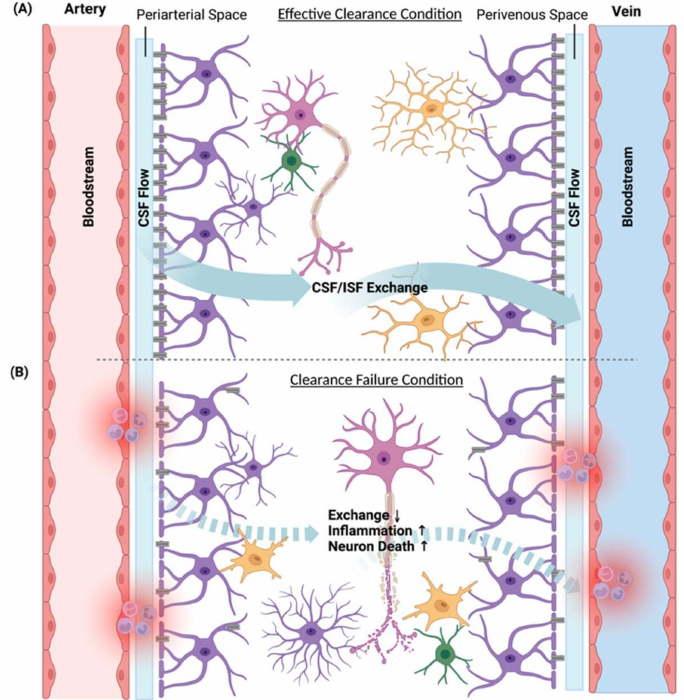
Figure 2. The glymphatic system. Structurally, the glymphatic space is a composite of the periarterial and perivenous space, surrounded by the blood vessel walls and vascular end-feet of astrocytes (in purple). Within the glymphatic spaces, arterial pulsations drive the flow of the cerebrospinal fluid (CSF), and the fluid enters the brain parenchyma via aquaporin-4 (AQP4) water channels. Lastly, this current will converge into the perivenous space. The exchanges between CSF and interstitial fluid (ISF) are particularly important for material exchanges and waste cleaning in the brain. Panel ( A ) shows effective cleaning of the metabolic waste in the glymphatic system. Neurons (in pink), microglia (in yellow), and astrocytes and oligodendrocytes (in green) are in normal conditions. In panel ( B ), during aging and chronic inflammation, a significant reduction occurs in the CSF/ISF flow exchanges due to age-related AQP4 depolarization. Furthermore, excessive immune cells in the perivascular spaces as well as sleep disturbances adversely affect the functioning of the glymphatic system, resulting in neuronal death and altered gene expression profiles in glial cells. We created this figure using BioRender.com, accessed on 19 July